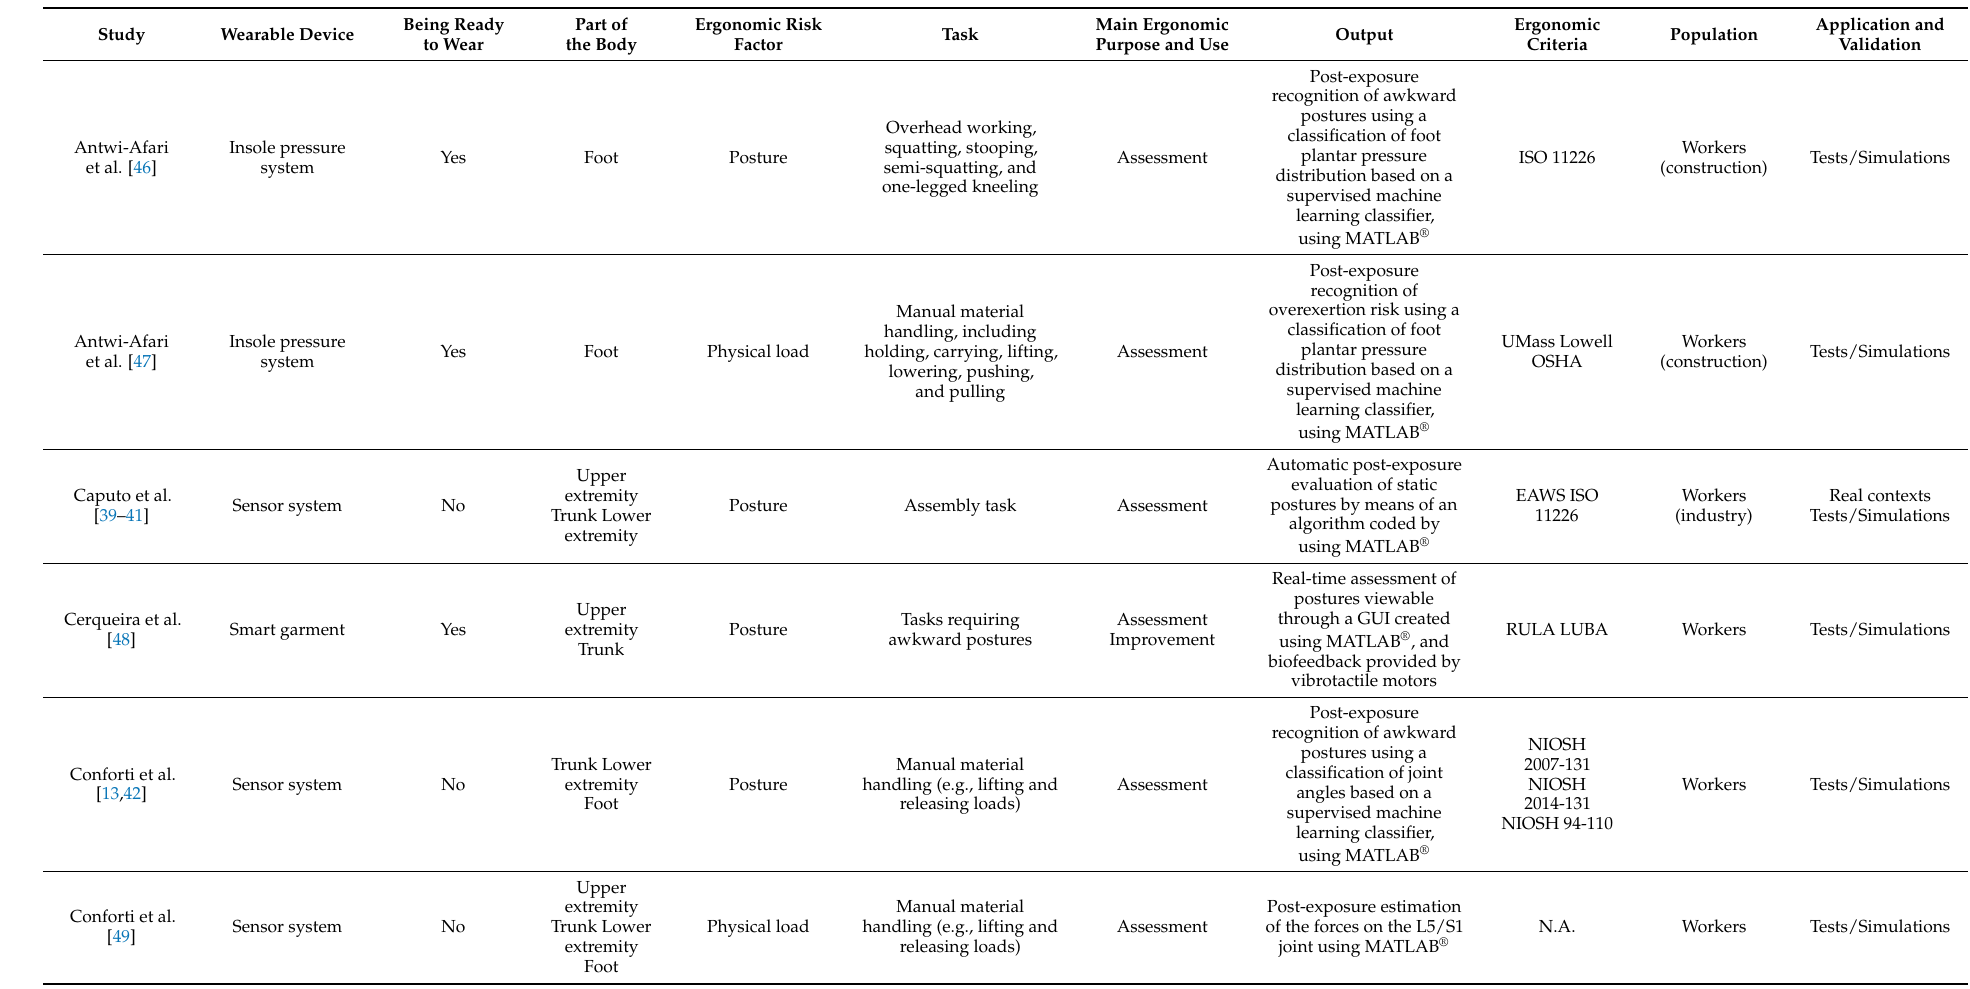
Table 3. Analysis and comparison of the 24 studies in the reviewed